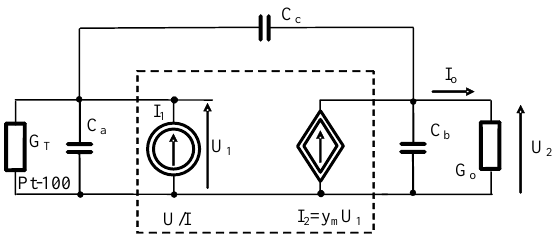
Figure 11. Small signal model of the temperature measurement line, where: G T —conductivity of Pt-100 sensor, U / I—transmitter 4–20 mA, G o —equivalent conductance of all resistances in the 4–20 mA current loop I o , C a,b,c —equivalent capacities of Pt-100 sensor and connecting cables, y m —transadmittance of transmitter R / I.